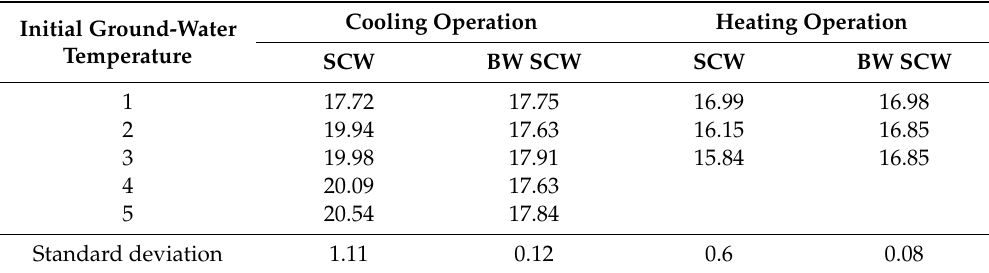
Table 7. Comparison of the initial groundwater